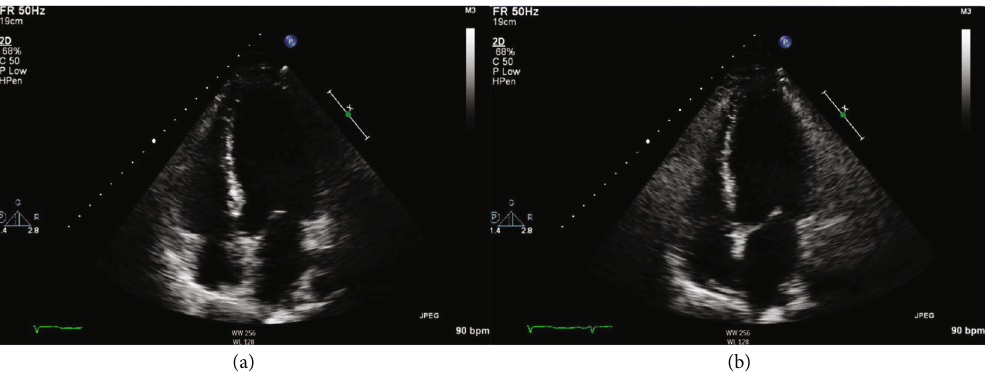
Figure 3: Four-chamber view of TTE demonstrates global wall motion hypokinesis and reduced LV systolic function on admission in the setting of a structurally normal heart on hospital day 3 after diuresis. (a) Four-chamber view during diastole. (b) Four-chamber view during systole with decreased contractility and minimal changes in LV